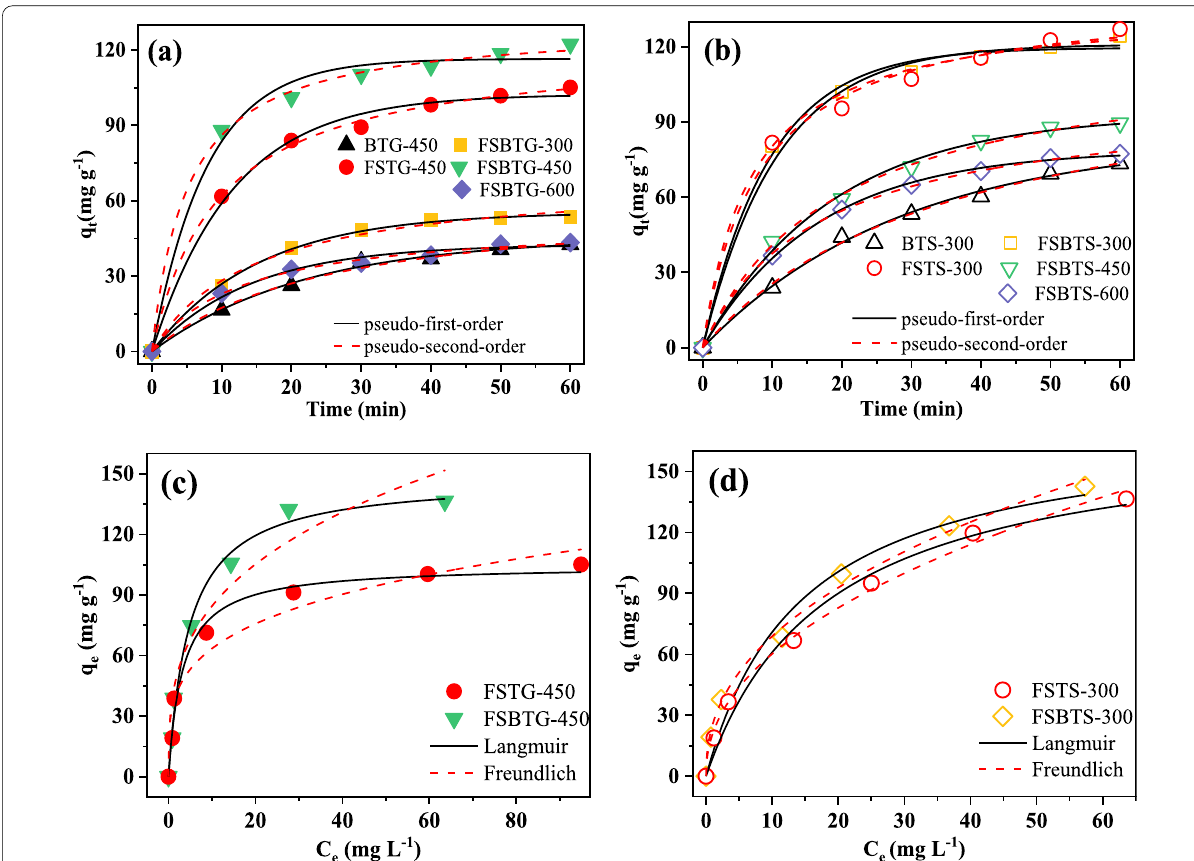
Fig. 4 Adsorption kinetics and adsorption isotherm for TC adsorption by g-C 3 N 4 -based photocatalysts ( a , c ) and CdS-based photocatalysts ( b , d ) (TC: